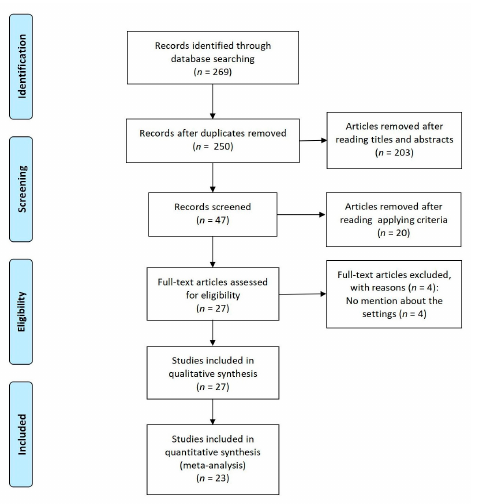
Figure 1. Flow diagram for the systematic review process.